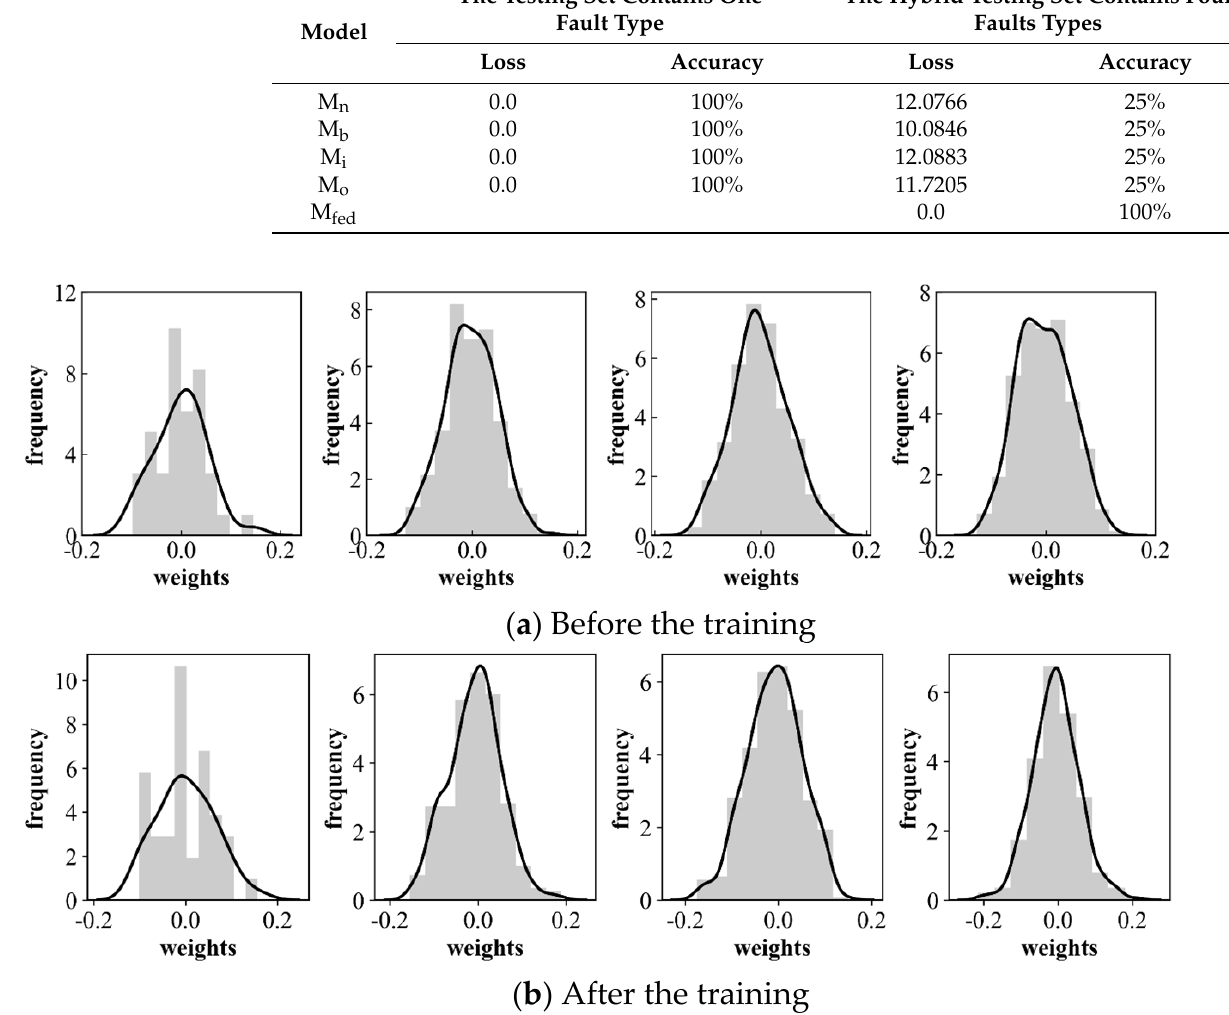
Figure 5. Weight distribution of the federated fault diagnosis model.